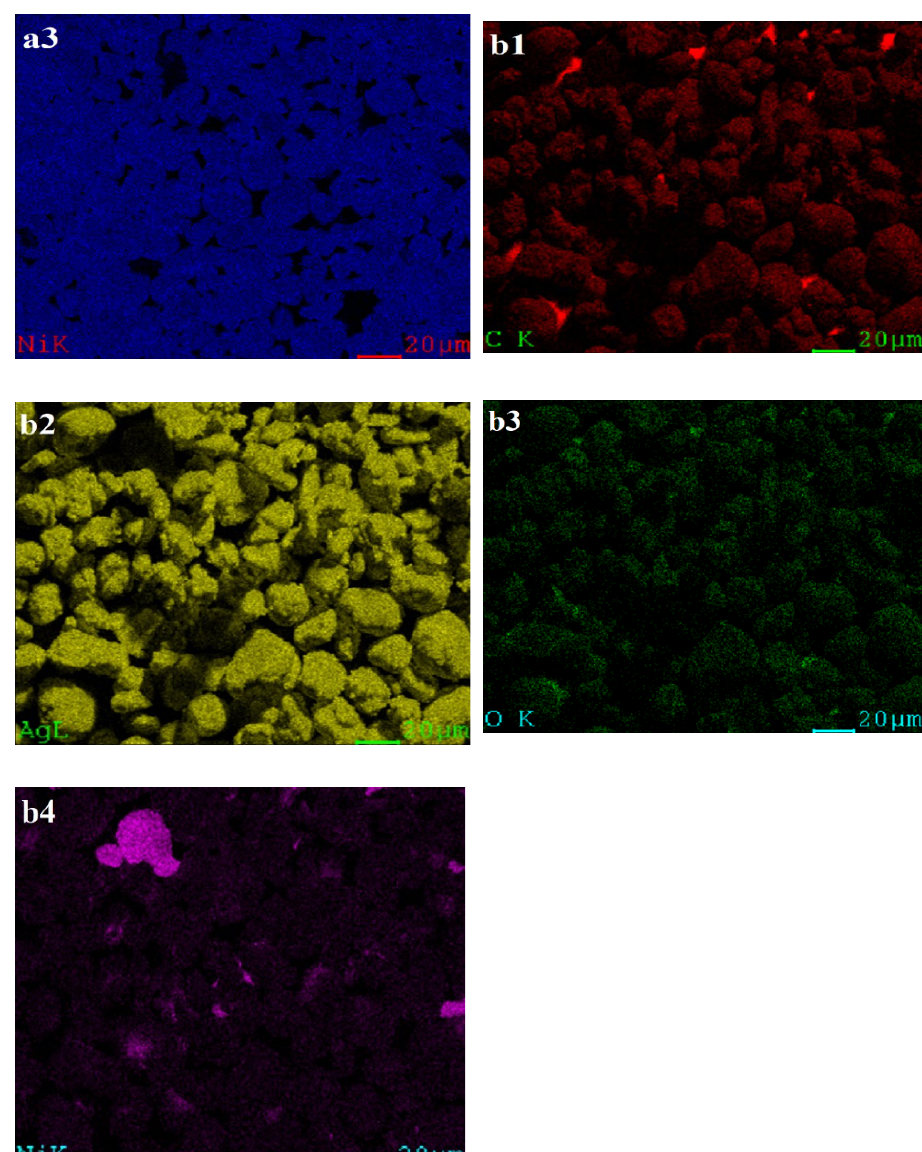
Figure 2. ( a ) EDS of Ni/C powder; ( b ) EDS of Ag/Ni/C powder; ( a1 – a3 ) Elemental distributions